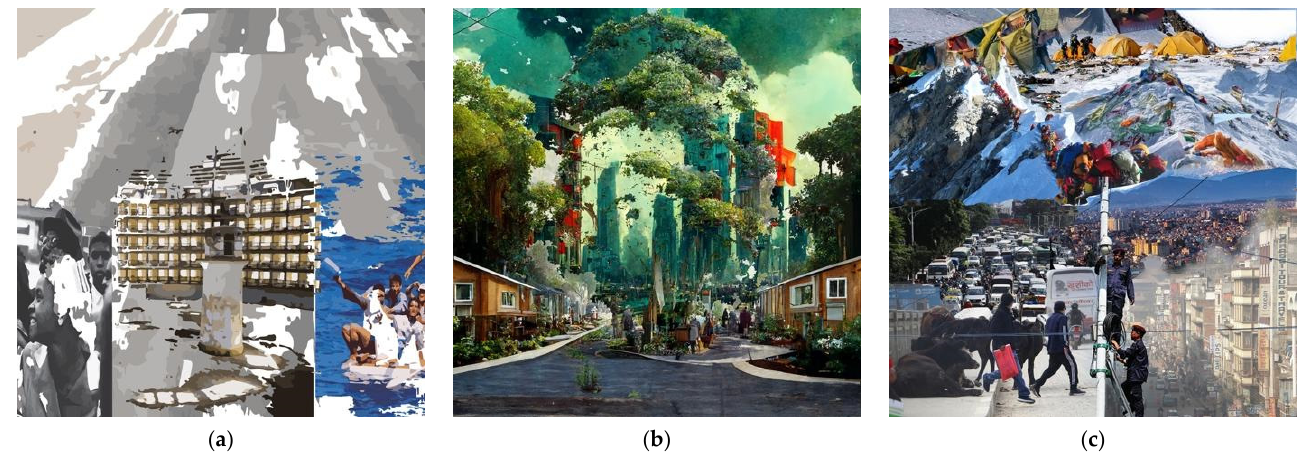
Figure 1. Various visualization techniques: ( a ) Cuban immigration poster using the image trace tool in Adobe Illustrator, created by Manuel Olivares, 2022 ( b ) utopian Forth Worth poster, AI-generated photo using words such as gentrification, culture, Hispanic, displacement, Mexican, history, and Forth Worth created by Desiray Rodriguez, 2022 ( c ) environmental crisis in Kathmandu, Nepal, using the collaging technique created by Nishan Khatiwada, 2022.